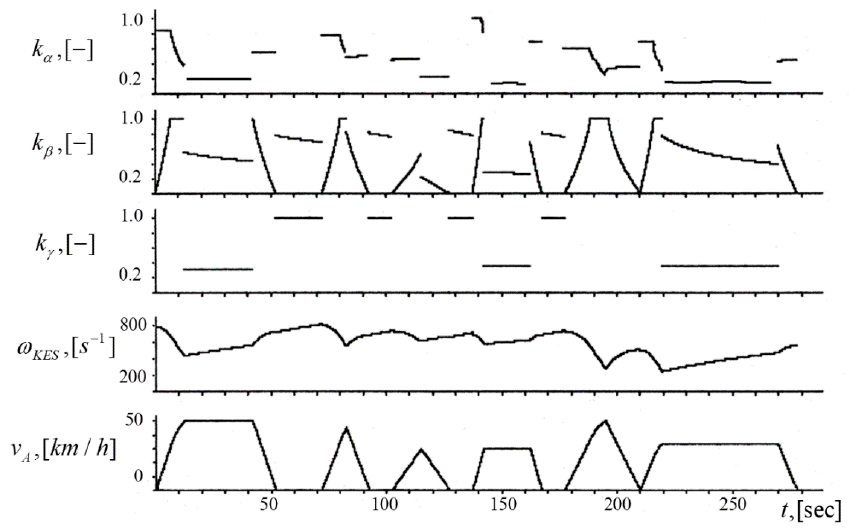
Figure 4. Simulation results of the considered hybrid driveline: dimensionless displacements of the separate hydromachines k α ( t ) , k β ( t ) , and k γ ( t ) , KES energy content, described by its rotor speed ω KES , over a defined speed profile v A ( t ) .